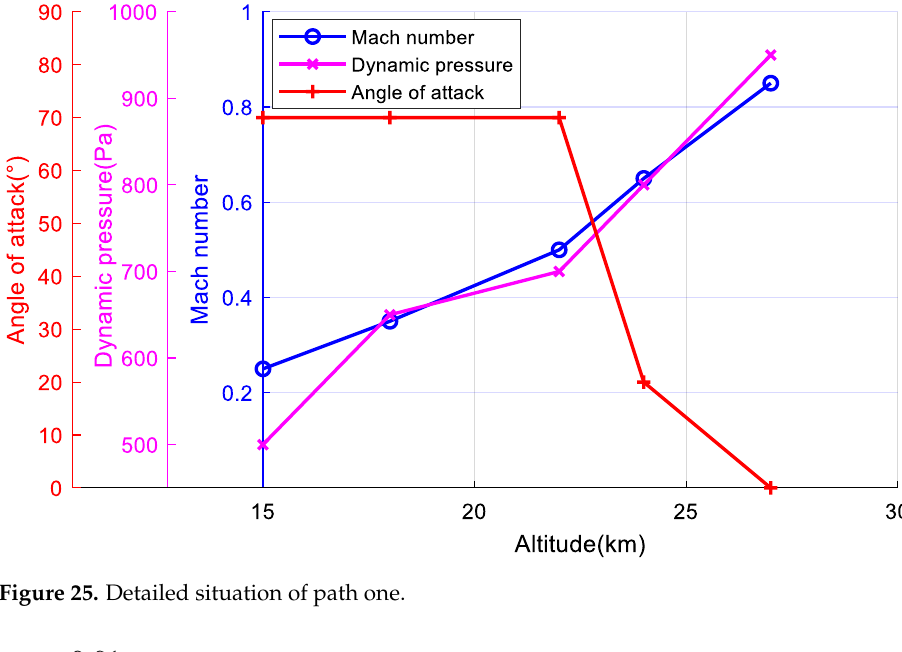
Figure 25. Detailed situation of path one.